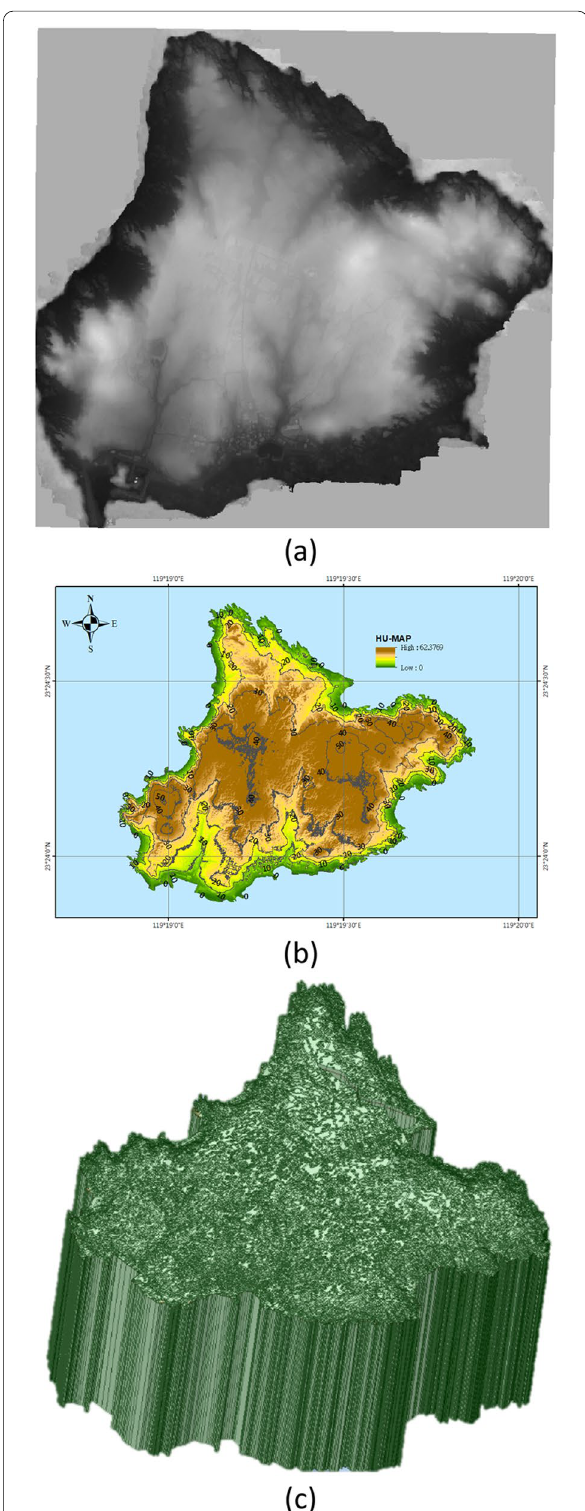
Fig. 6 Huayu’s topography: a DEM, b Digital topography processed by ArcGIS ® , c 3D geological model generated by SpaceClaim ®